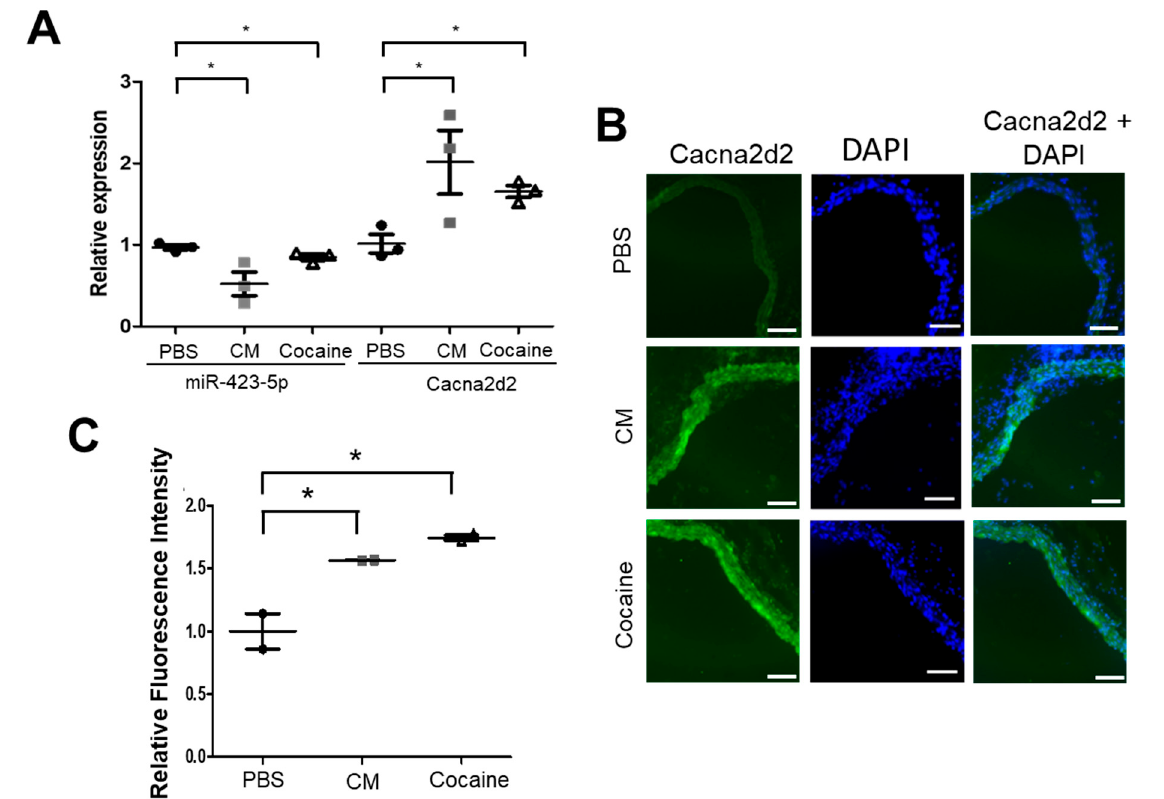
Figure 1. Cocaine and CM suppress miR-423-5P expression and increase Cacna2d2 expression in the mouse aortas. ( A ) QRT-PCR analysis was performed using RNA extracted from aortas isolated from mice treated with saline, cocaine, or CM for 10 consecutive days. Cocaine and CM resulted in decreased miR-423-5p expression and increased Cacna2d2 expression compared to saline treatment. Black circles = saline treatment, gray squares = CM treatment, open triangle = cocaine treatment (* p < 0.05 vs. saline). ( B ) Immunohistochemical (IHC) analysis of Cacna2d2 levels in aortic sections showed cocaine and CM treatment induced increased levels of Cacna2d2 protein expression compared to saline. Scale bars = 100 µ m, magnification 20 × (PBS group), 50 µ m magnification 40 × (CM and Cocaine groups) ( C ) The intensity of Cacna2d2 positive staining was quantified using Image J software. Student’s two tailed t -test was used for all statistical analysis (* p < 0.05 vs. saline).